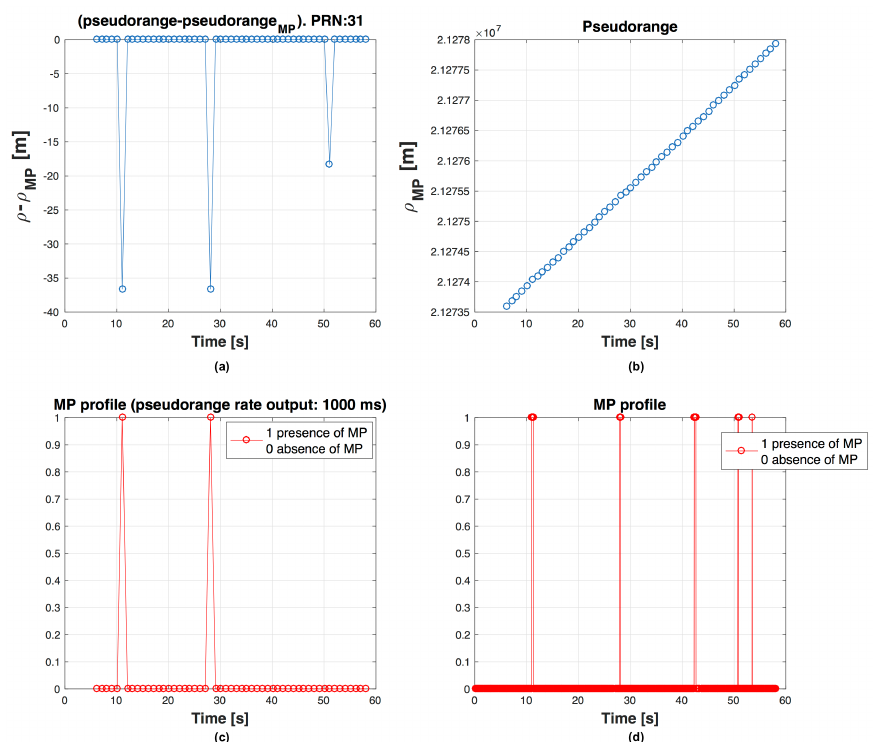
Figure 5. Behaviour of PR for PRN 31, with output every ∆ T ρ = 1000 ms. PR error ( ρ clean − ρ MP ) ( a );